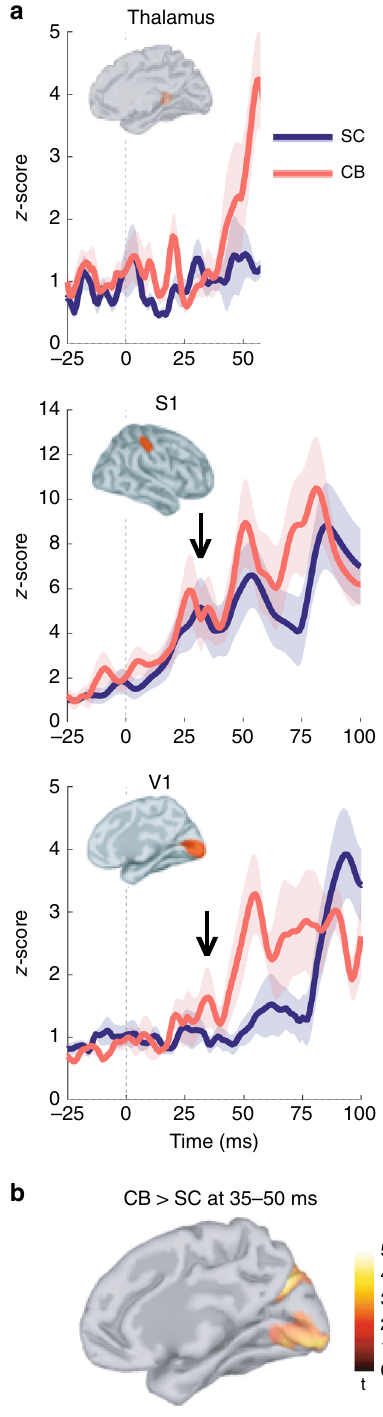
Fig. 1 Neurophysiological responses following left index fi nger stimulation. a The source traces of MEG data were estimated across the cortical surface and extracted from regions of interest in thalamus, S1 and V1 in congenitally blind (CB) and sighted control (SC) subjects. The electrocutaneous fi nger stimulation occurred at 0ms. Shading indicates the standard error of the mean (SEM) for each group. The signi fi cant S1 response in CB and SC and the early V1 response in CB only are indicated by black arrows. b Cortical activations between 35 and 50ms following left index fi nger stimulation were stronger in CB vs. SC subjects over contralateral parieto-occipital regions ( p < 0.05 uncorrected, permutation test with 5000 randomizations, t-test unequal variance). Medial view of the right